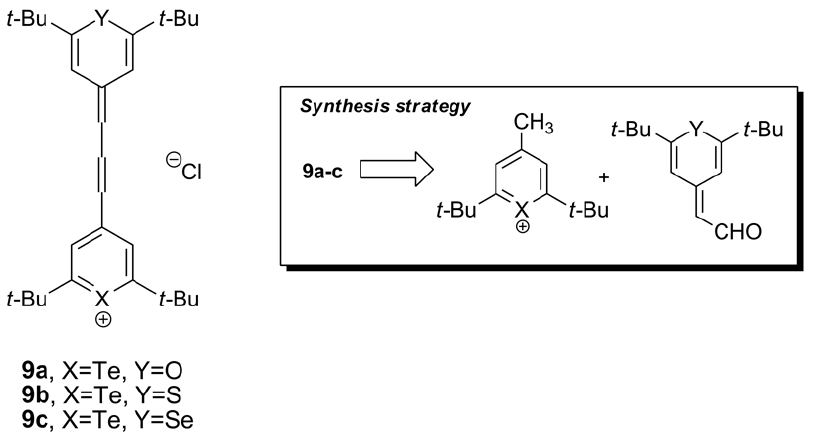
Fig. 7 – Molecular structure of chalcogena-pyrilium salts and the main strategy for its preparation.